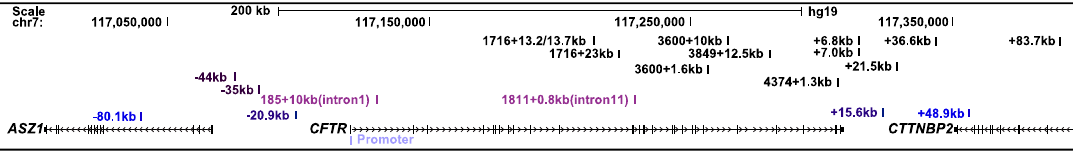
Figure 2. CFTR locus and important functional elements. University of California Santa Cruz (UCSC) genome browser displaying CFTR and nearby genes. Airway-selective enhancer elements at − 35 kb and − 44 kb are shown in dark purple. Intestinal-selective enhancer elements 185 + 10kb (intron 1) and 1811 + 0.8kb (intron 11) are shown in medium purple. Insulator elements at − 20.9 kb and + 15.6 kb are shown in dark blue. TAD boundaries at − 80.1 kb and + 48.9 kb are shown in medium blue. CFTR promoter is shown in light purple. Other key DNase I hypersensitive sites (DHS) are shown in black.